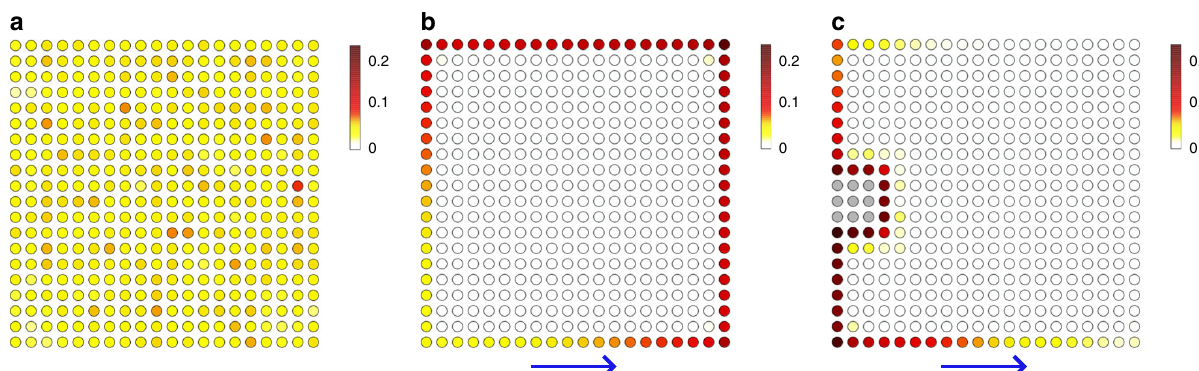
Fig. 5 Real-space simulation of the lasing edge modes. a – c The color represents the probability amplitude at each site, which is normalized so that the sum of squares gives unity. We set the parameter u = − 1 throughout the calculations in this fi gure. a Without the non-Hermiticity ( β ¼ β 0 ¼ 0), all the bulk modes can survive for a long time and thus lasing of edge modes fails to happen. b With the non-Hermitian coupling ( β = 0.2, β 0 ¼ 0 : 1), only the edge mode is enhanced even if we start from a random initial state. We can also con fi rm the propagation of the wave packet. c Starting from the excitation of one site at the edge, we con fi rm that a wave packet propagates along the edge of the sample. Even in the presence of distortion at the edge (represented by the gray sites), the edge wave packet avoids it and propagates without dissipation. The parameters used are β = 0.9 and β 0 ¼ 0 : 8.